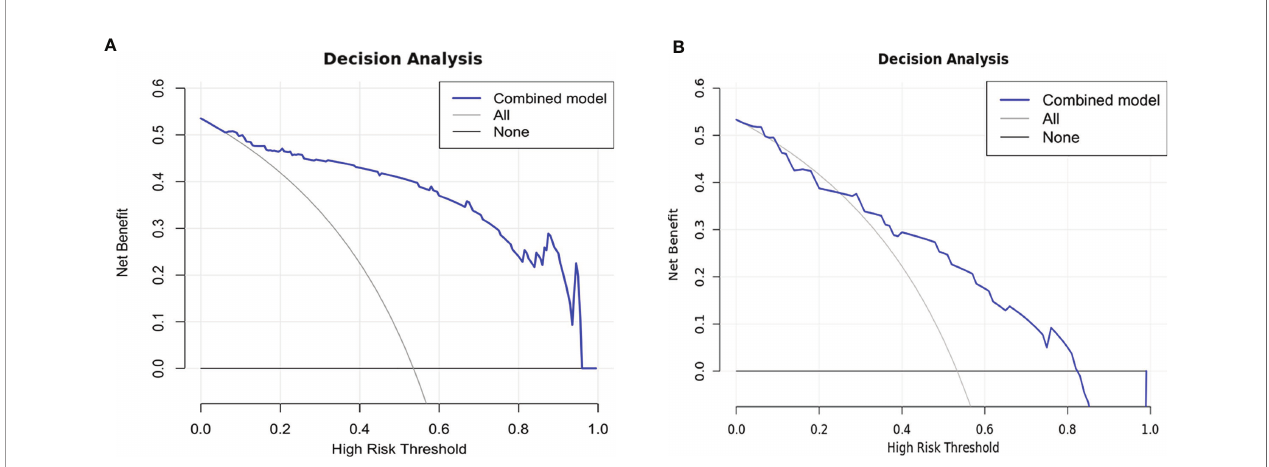
FIGURE 6 | Decision curves of training (A) and test (B) datasets. The net bene fi t is shown on the y-axis, while the threshold probability is represented on the x-axis. The blue line represents the combined model ’ s bene fi t. The grey and black lines depict the tactics of “ treating everyone ” and “ treating none ” ,